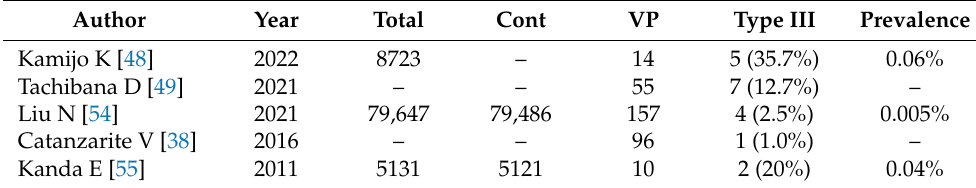
Table 5. Prevalence of type III vasa